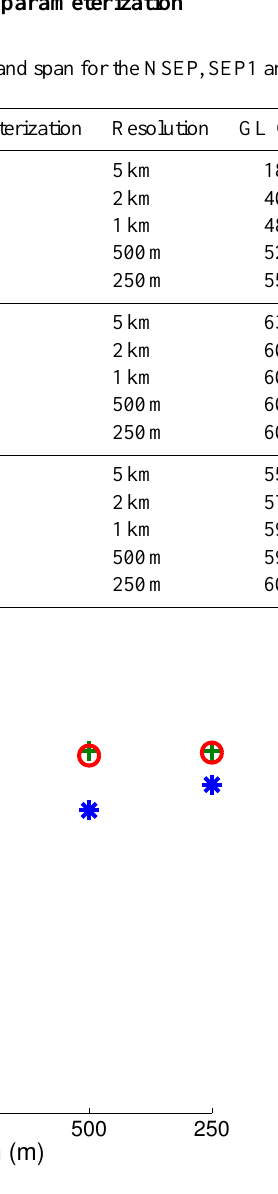
Figure 2. Steady state grounding line position in y = 0 as a function of mesh refinement for NSEP (blue stars), SEP1 (green crosses) and SEP2 (red circles).